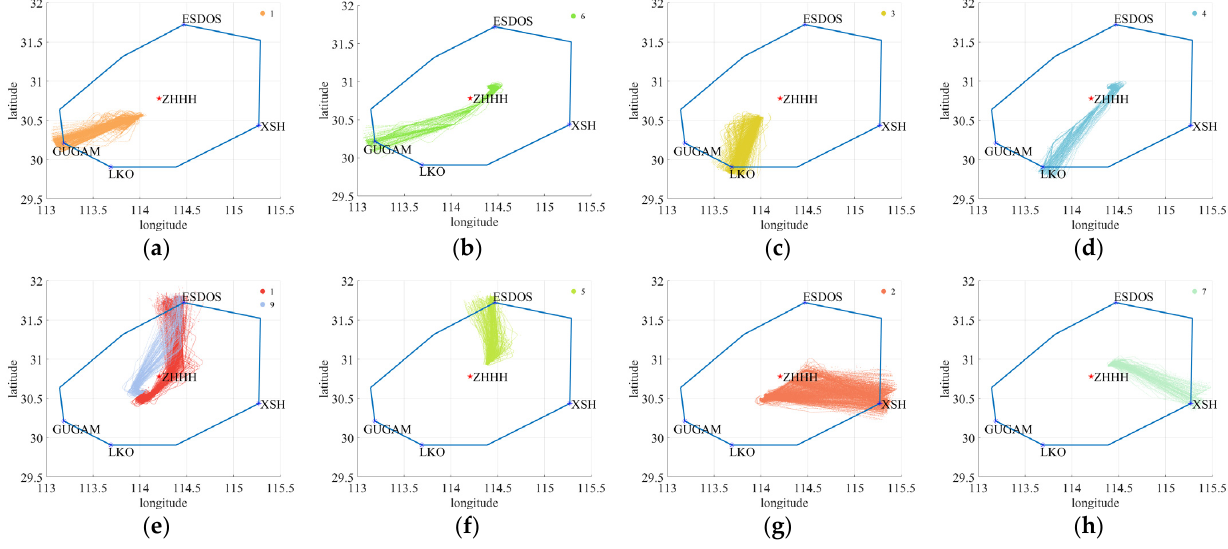
Figure 8. Clustering results of flight trajectories of ZHHH (OPTICS). ( a ) AG: GUGAM, Direction: North; ( b ) AG: GUGAM, Direction: South; ( c ) AG: LKO, Direction: North; ( d ) AG: LKO, Direction: South; ( e ) AG: ESDOS, Direction: North; ( f ) AG: ESDOS, Direction: South; ( g ) AG: XSH, Direction: North; ( h ) AG: XSH, Direction: South.